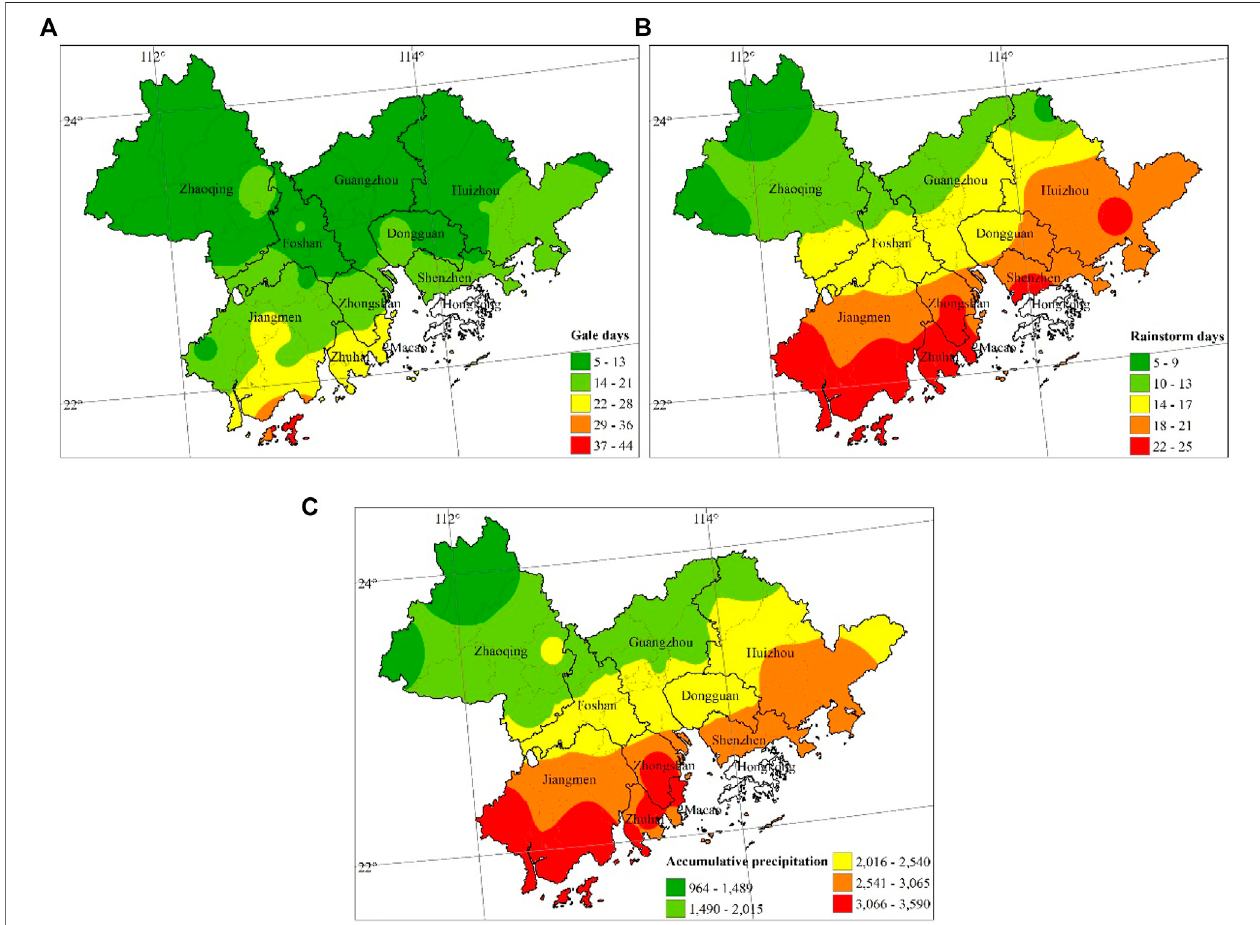
FIGURE 6 | Cumulative typhoon (A) gale days, (B) rainstorm days, and (C) precipitation in the GBA during 2009 – 2020.